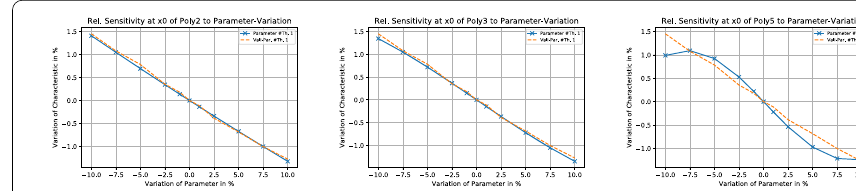
Fig. 19 Sensitivity to thickness for second, third, and fifth order model